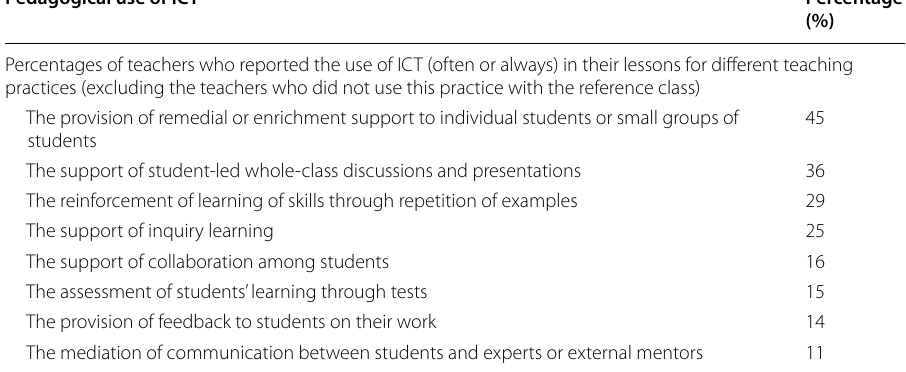
N 420 teachers; alternative weighting approach; teacher practices ordered by the size of the percentage =